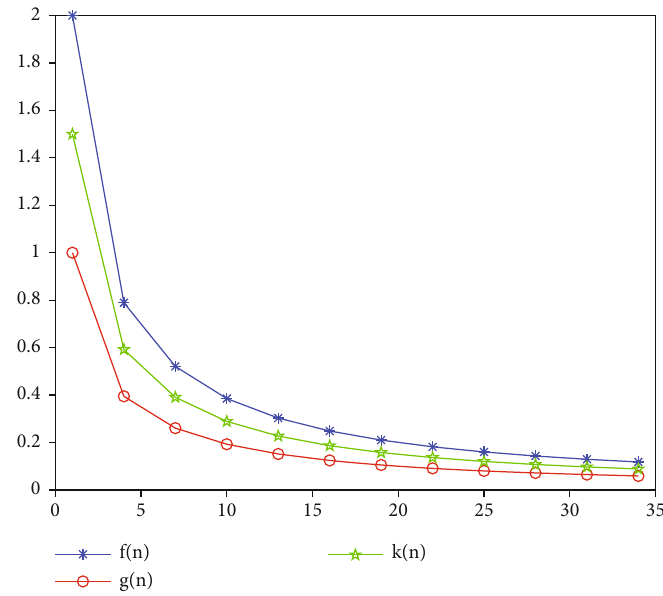
Figure 1: Example 1. Convergence behavior f f